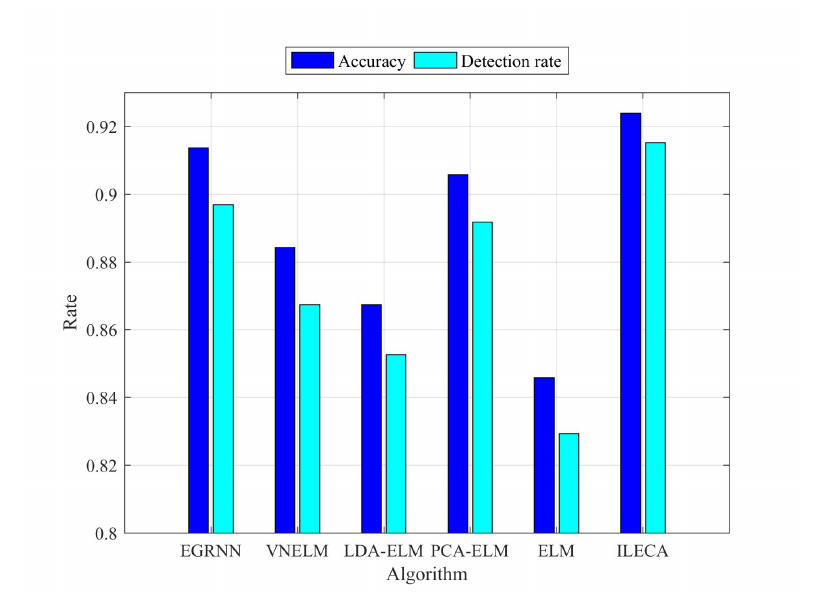
Figure 13. Accuracy and detection rate. Table 5. Algorithm